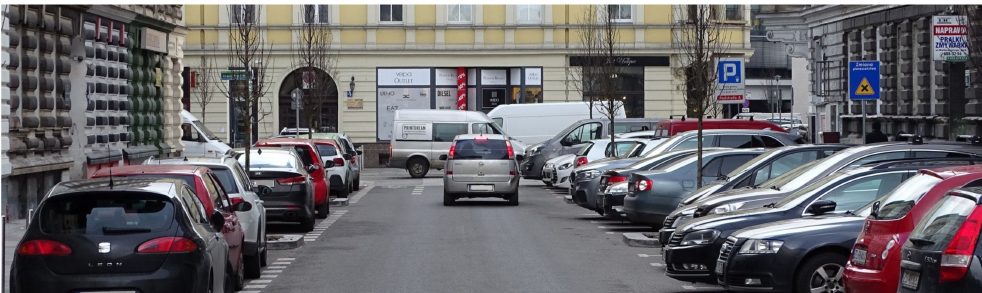
Figure 4. Queue of vehicles in testing ground No. 3, and two-way queue of vehicles on the transverse two-way street. Source: own work of the